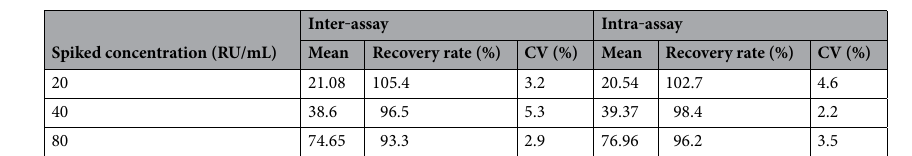
Table 3. The precision of QD-ICA at three spiked levels. Spiked concentration is defined as the final concentration of the samples added to calibration serum. CV coefficient of variation. Recovery rate (%) = (recovery concentration/spiked concentration) × 100%. CV (%) = (standard deviation/mean) × 100%.